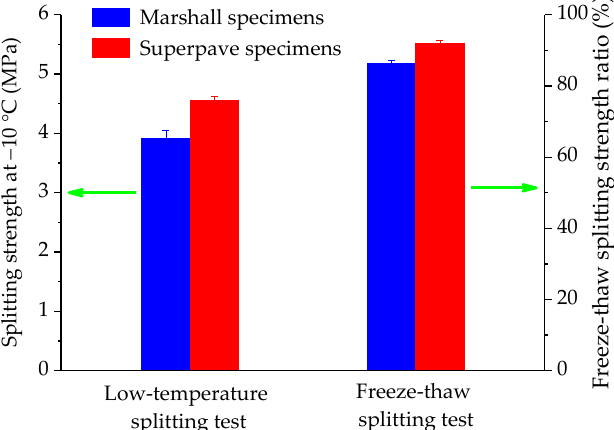
Figure 13. Comparative result of the low-temperature and freeze-thaw splitting tests.